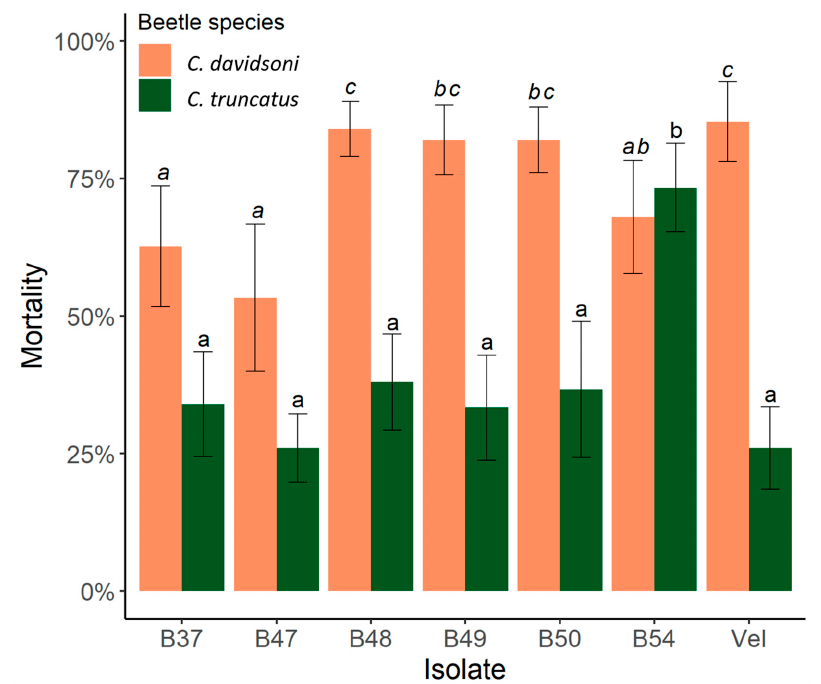
Figure 3. Average mortality rate of larval Carpophilus spp. treated with 10 6 conidia/g vermiculite. Di ff erent letters denote significant di ff erence ( p < 0.05) through GLM analysis with post-hoc Different letters denote significant difference ( p < 0.05) through GLM analysis with post-hoc Tukey HSD test within beetle species. Error bars represent 95% confidence intervals.